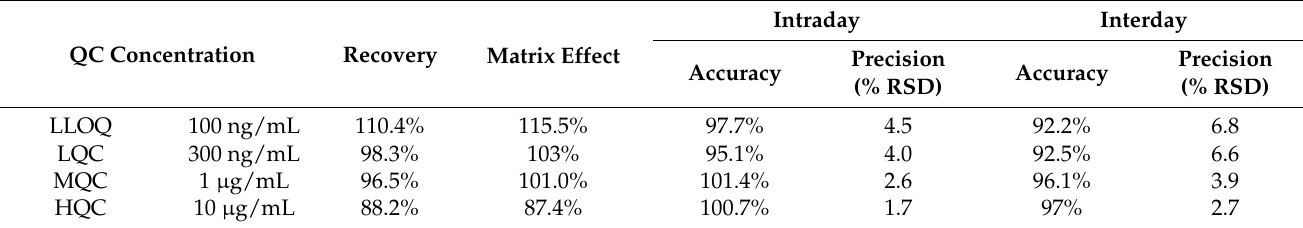
Table 3. Extraction recovery, matrix effect, accuracy, and precision of cyanide-PFB in human blood at four QC concentrations (0.1, 0.3, 1, 10 µ